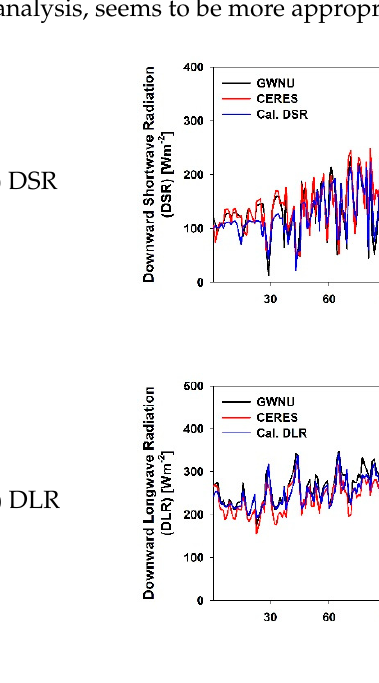
Figure 9. Daily mean time series distribution of GWNU observatory, CERES, and calculated ( a ) DSR and ( b ) DLR. Observation at GWNU observatory are missing in Julian day 108–110 and 295–301. Table 11. Bias, RMSE, and correlation coefficient (R) of DSR and DLR observed at the GWNU observatory and CERES and calculated DSR and DLR. The mean, bias, and RMSE units are Wm − 2 . Observation Mean